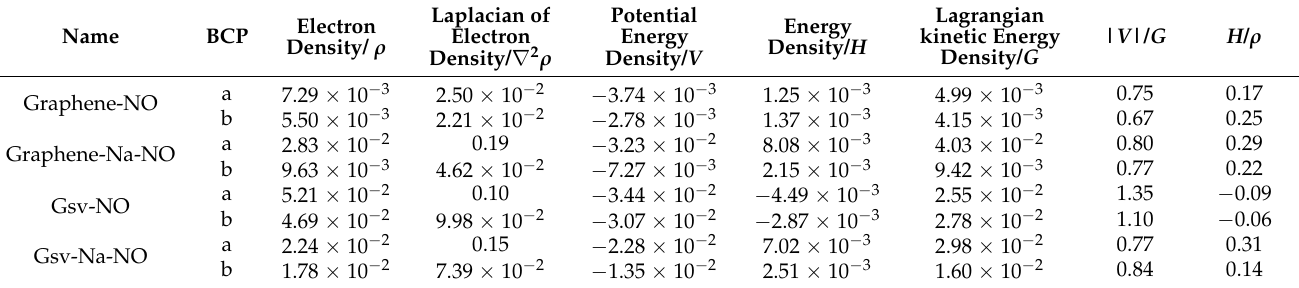
Table 1. Values of real space function in the AIM